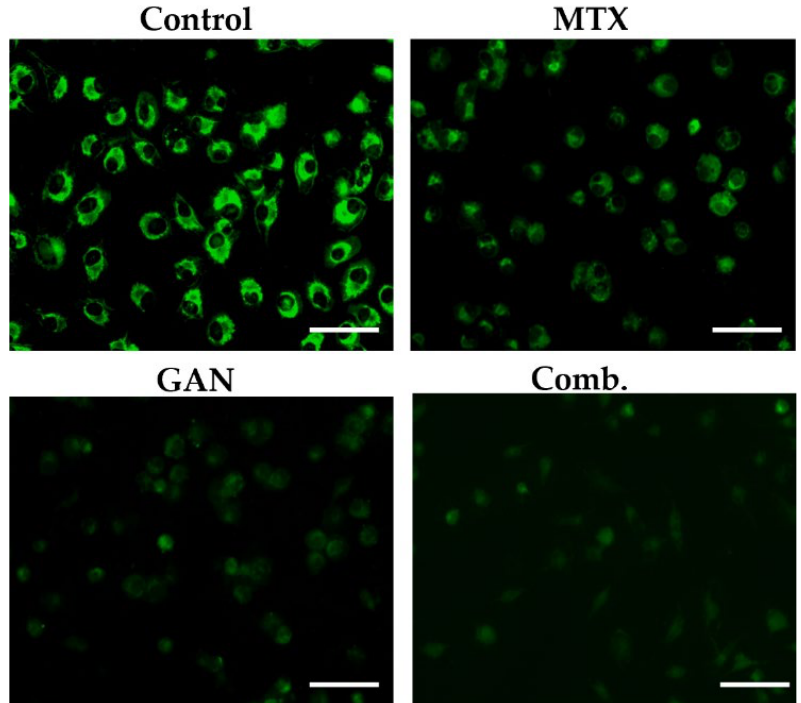
Figure 4. Dissipation of mitochondrial membrane potential in A549 lung cancer cells after treatment with individual and combined GAN/MTX doses compared to untreated control. Scale bar = 100 µm, Magnification: 20×.